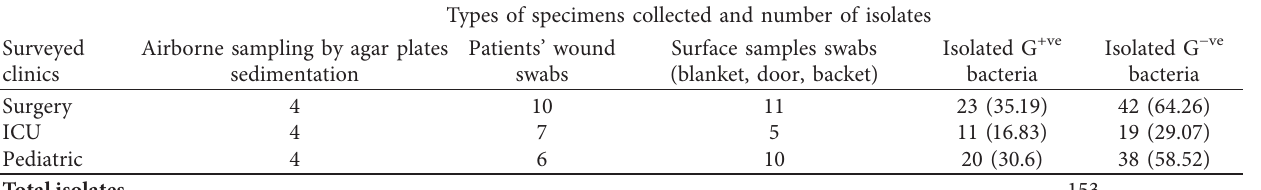
Table 1: Numbers and frequency of bacteria isolates in the different wards of